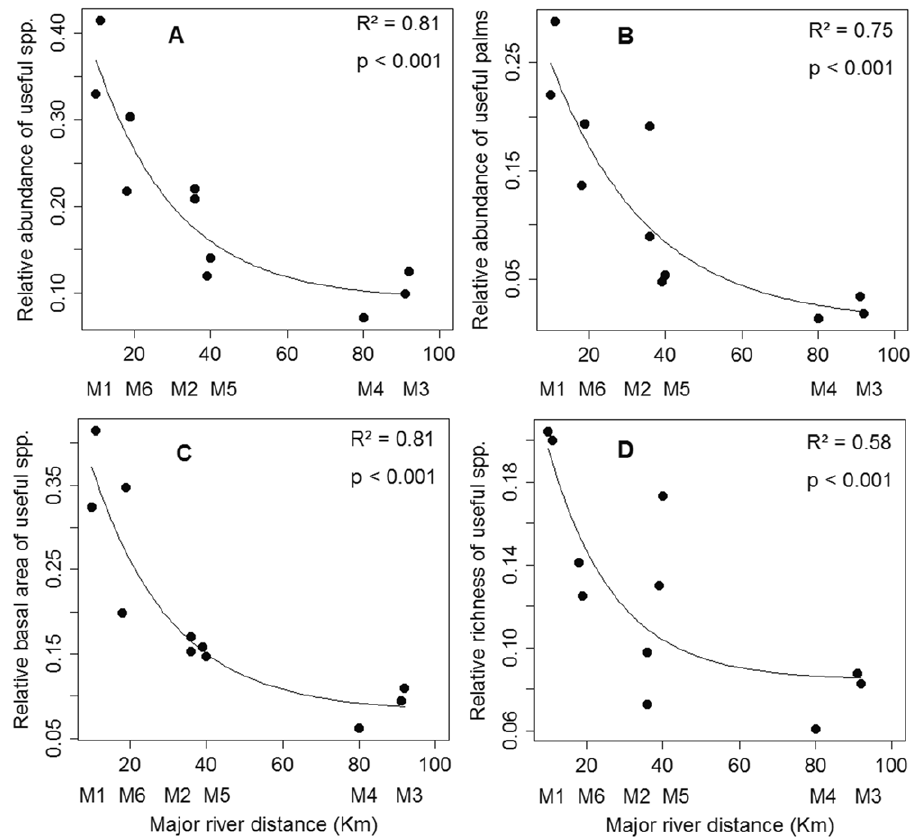
Figure 3. Relationships between useful tree parameters and the distance to major rivers. Relationships between the useful trees parameters and the distance to the relative abundance of useful species per plot (A), the relative abundance of useful palms per plot (B), the relative basal area of useful species per plot (C) and the relative richness of useful species per plot (D), with the distances from major rivers. Points are the plots of all sites, totaling 11 plots. The shortest straight line distance in km from the plot to the Solimo˜es, Purus or Madeira River was